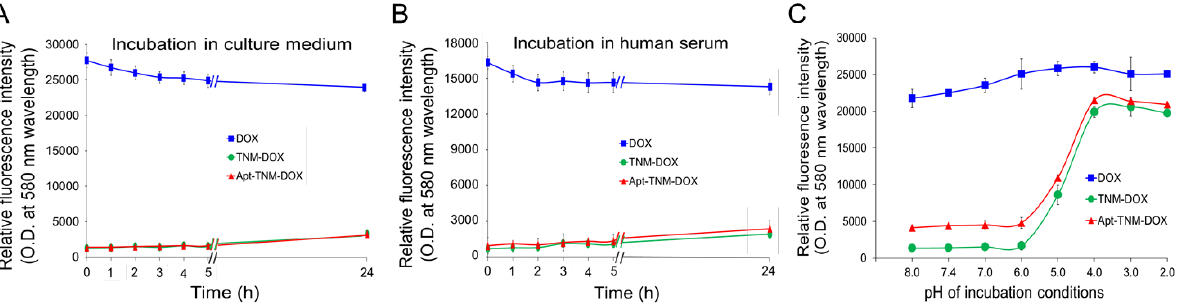
Figure 5. pH-controlled drug release by Apt-TNM-DOX. (A and B) Stability assays. TNM-DOX and Apt–TNM-DOX were incubated in culture medium ( A ) or human serum ( B ). Changes in fluorescent signals from free DOX were measured kinetically. ( C ) Drug release assay. TNM-DOX and Apt–TNM-DOX were incubated in culture medium at different pH conditions as indicated at 37 ˚C for 30 min. Resultant changes in fluorescent signals from released free DOX under each condition were quantified.